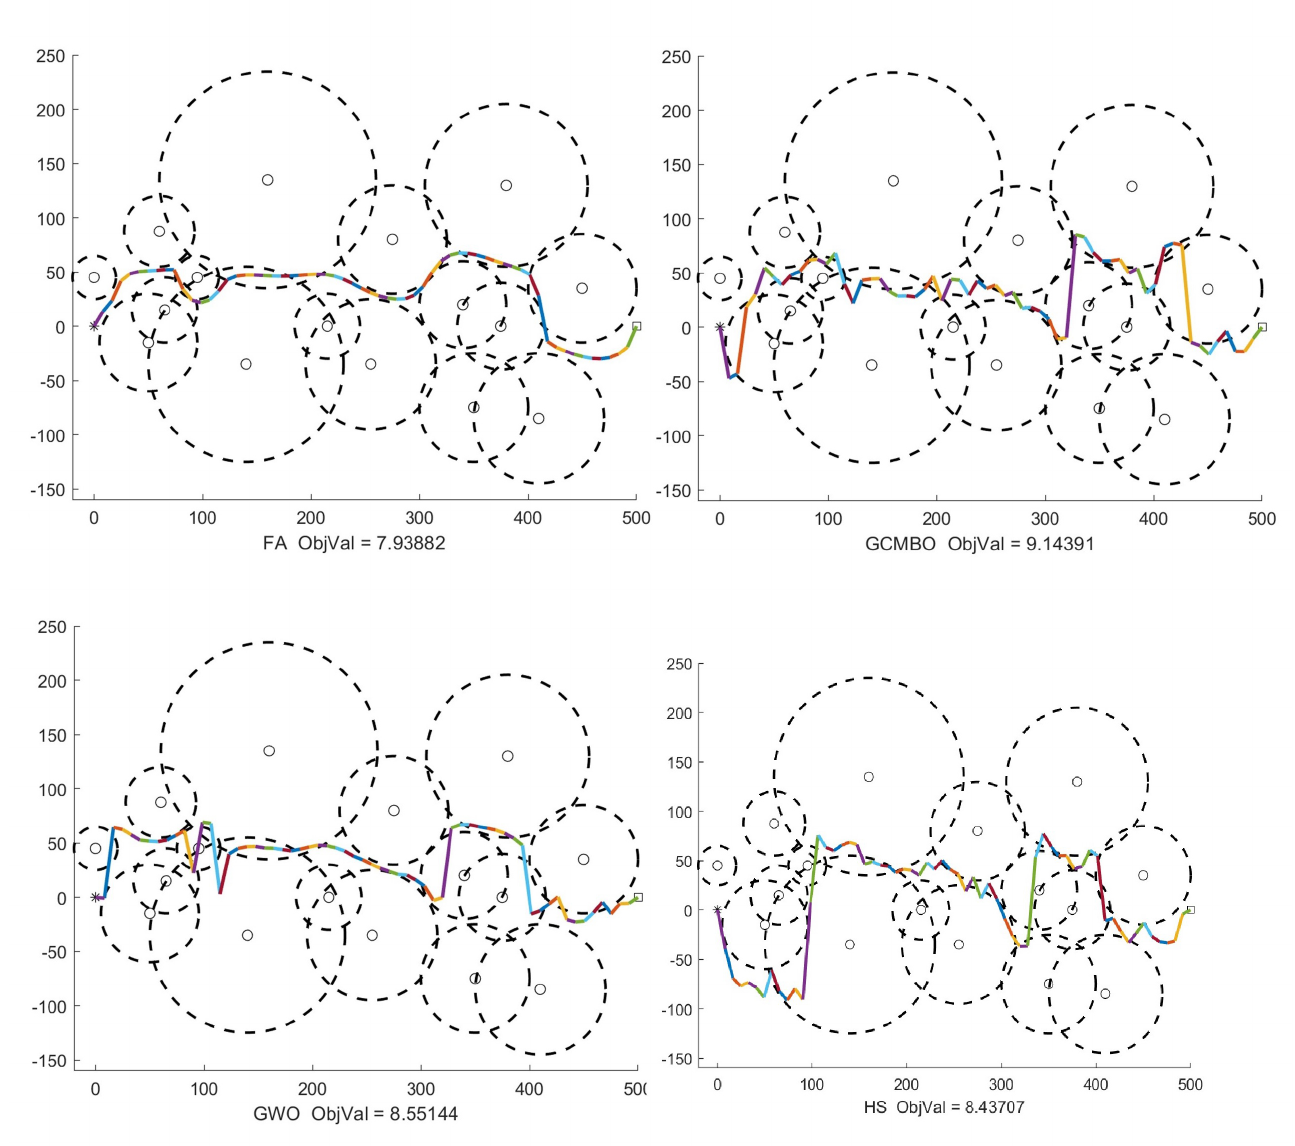
Figure 10. The comparison performance of different swarm intelligence algorithms FA, GCMBO, GWO and HS for Case 8 with D = 60, N =